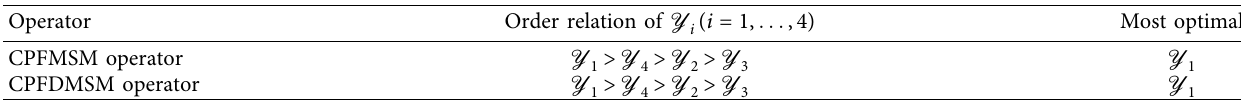
Table 8: Sorting of each